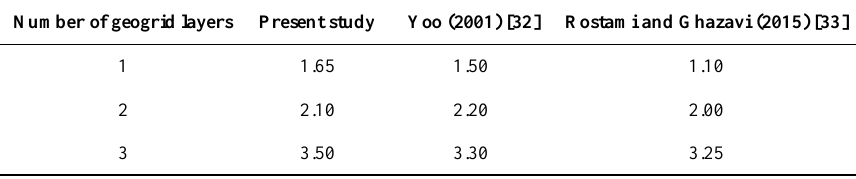
Table 2. A Comparison between the calculated bearing capacity ratio with analytical and experimental model